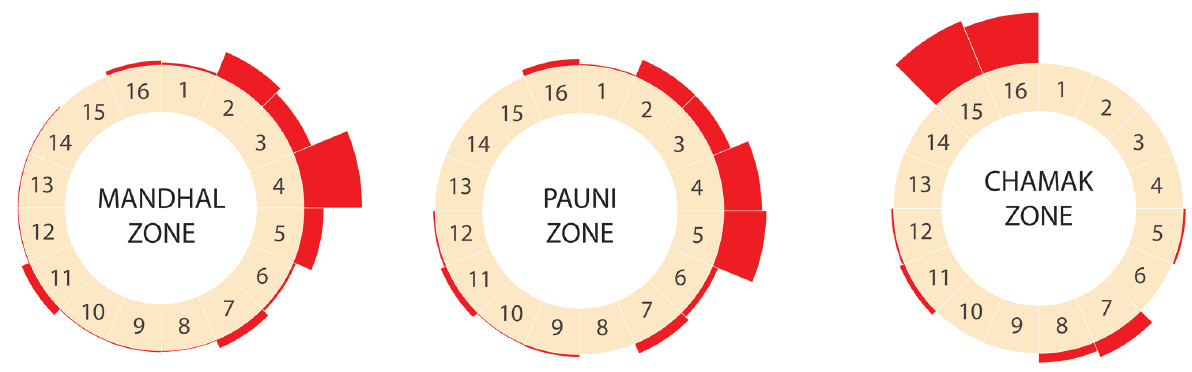
Figure 45: Charts illustrating the proportions of each class of pottery relative to each other in each survey zone. Numbers on the inner cir- cumference indicate the ceramic classes (as defined in this